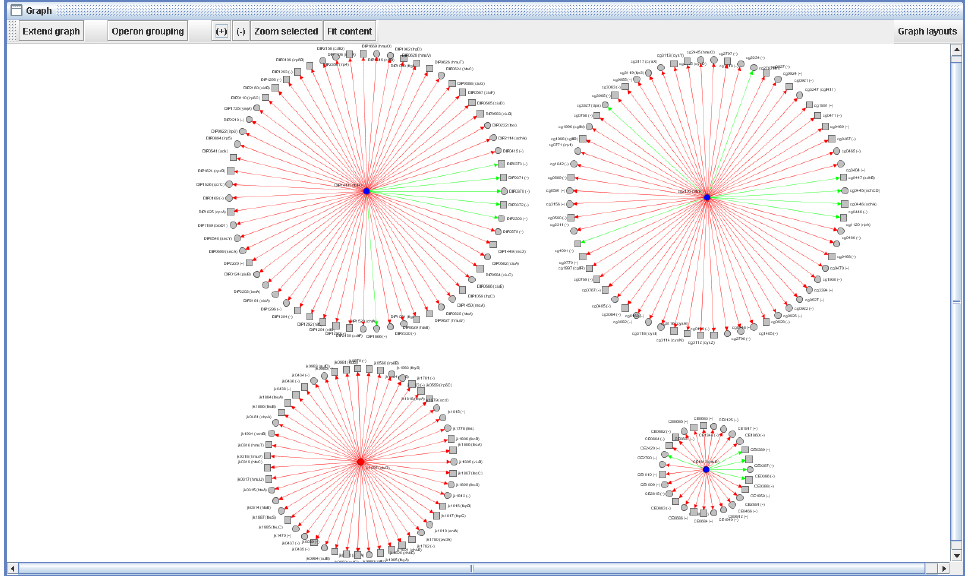
Figure 4: Comparative visualization of the DtxR regulons of C. diphtheriae (top left), C. glutam- icum (top right), C. jeikeium (bottom left) and C. efficiens (bottom right). The graph was generated by means of the yFiles Java graph library using the circular layout style with a depth cut-off of 1 not including genes from regulations. Color code: red node and line: repressor and repressing interaction; green line: activating interaction; grey circles and grey squares: target genes with binding sites and target genes in operons; blue node: dual